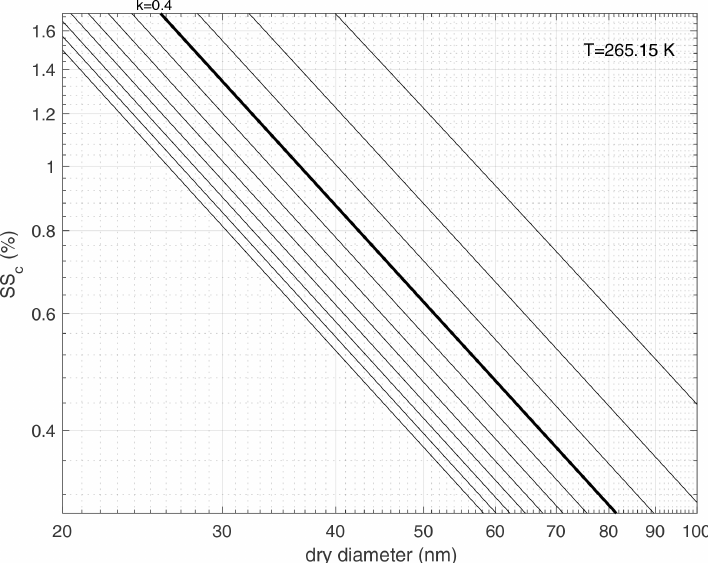
Figure A12. Calculated critical supersaturations SSc (in percent) as a function of dry diameter, computed for σs/a = 0 . 072Jm − 2 and T = 265 . 15K. κ lines are shown for a range 0 . 1 ≤ κ ≤ 1 . 1. Bold line corresponds to κ =